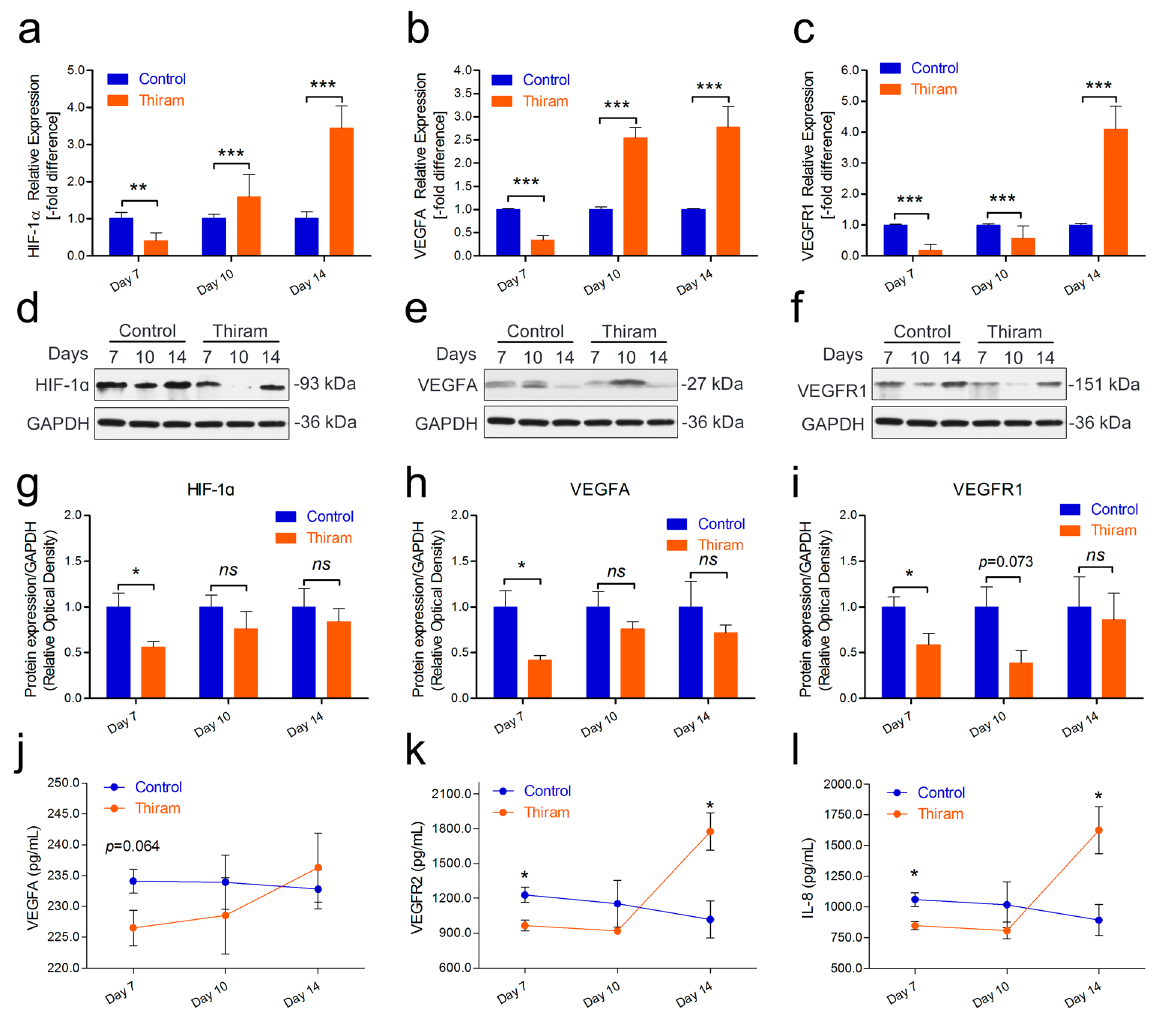
Figure 8. Thiram inhibits angiogenesis-related mRNA and protein expression. ( a – c ) The mRNA expression levels of HIF-1 α , VEGFA, and VEGFR1 were determined by qRT-PCR. mRNA expression levels from the control group were normalized to 1. GAPDH was used as the loading control. The results are representative of at least three independent experiments, which were run in triplicate, and are expressed as the mean ± SD. Student’s t -test, ** p < 0.01, *** p < 0.001, n = 3. ( d – f ) The protein expression levels of HIF-1 α , VEGFA, and VEGFR1 were determined by Western blotting. ( g – i ) The results of the western blots were quantified and analyzed using Image-Pro ® Plus 6.0. Student’s t -test, * p < 0.05, ** p < 0.01, n = 3; Error bars indicate SEM. ns, not significant. ( j , k ) The serum concentrations of VEGFA, VEGFR2, and IL-8 were measured using ELISA kits. Student’s t -test, n ≥ 3; Error bars indicate SEM.